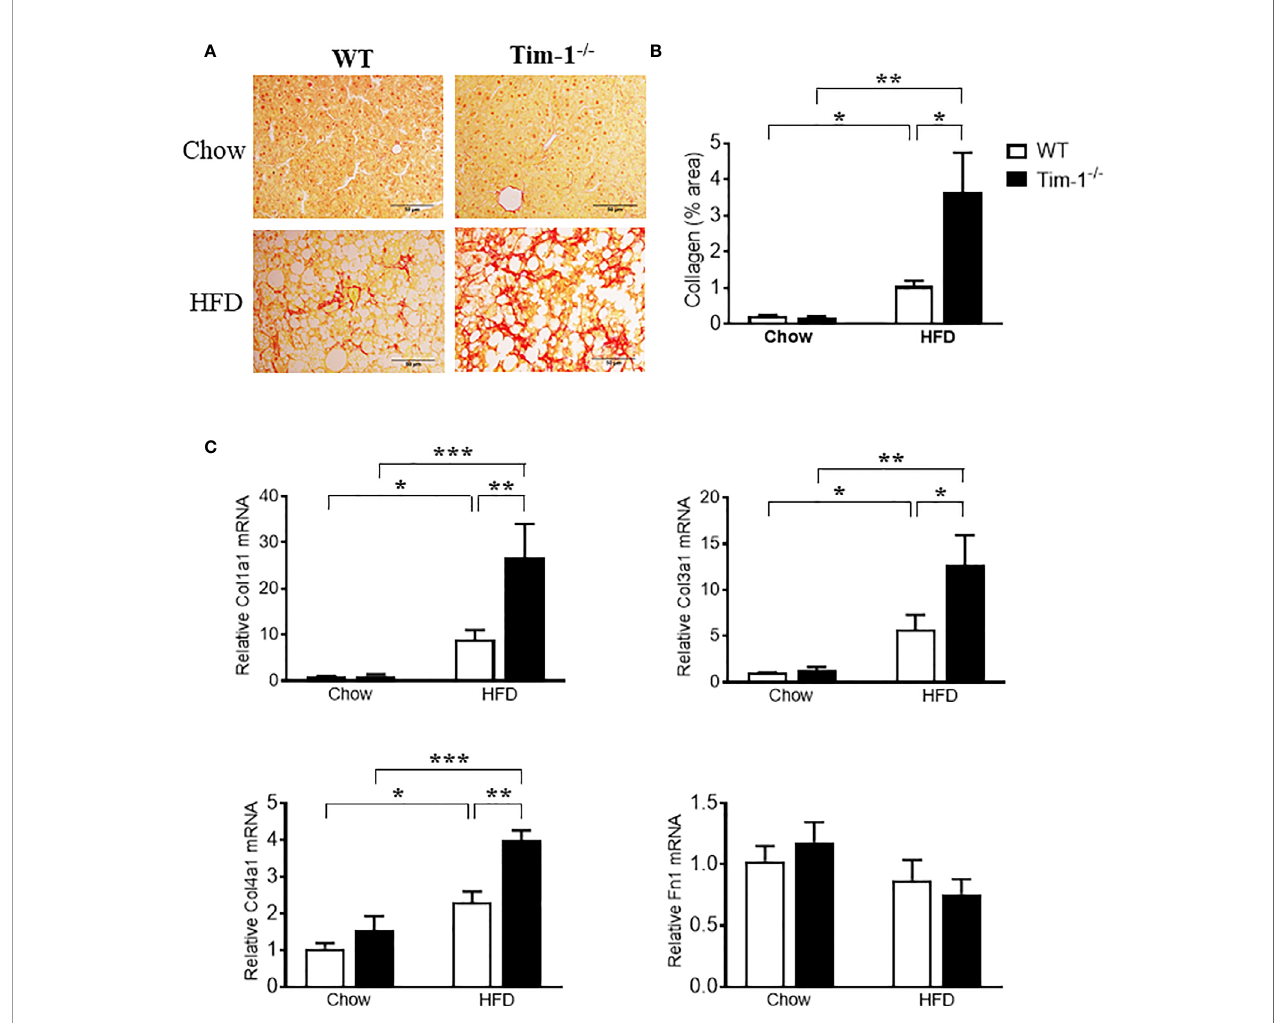
FIGURE 7 | Tim-1 de fi ciency accelerated HFD-induced liver fi brosis. (A) Representative images of Sirius Red staining to identify collagen deposition in liver sections from chow or HFD-fed WT and Tim-1 -/- mice. (B) Quantitative analysis of Sirius Red-stained liver tissue sections. (C) Real-time qPCR analysis of hepatic gene expression of type I (Col1a1), type III (Col3a1), and type IV (Col4a1) collagen as well as fi bronectin (Fn1) in chow or HFD-treated WT and Tim-1 -/- mice. Values are mean ± SEM. n=4-6 mice. Statistical differences were assessed by one-way ANOVA with Tukey ’ s multiple comparisons test; * P < 0.05, ** P < 0.01, *** P <